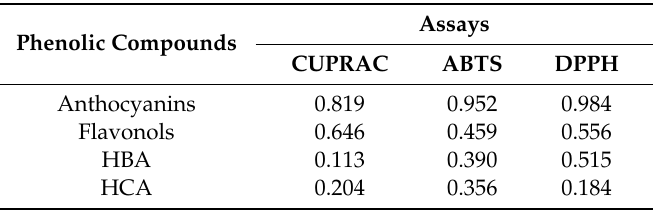
Table 13. Correlations between antioxidant activities and phenolic compounds (Anthocyanins. Flavonols, HBA, HCA). Assays Phenolic Compounds CUPRAC ABTS DPPH